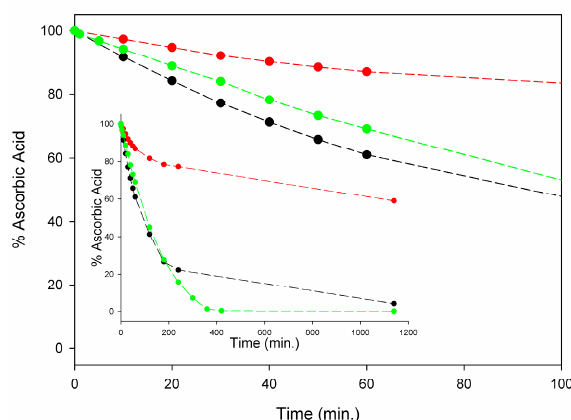
Figure 3. Stability of 100 µM ascorbic acid (AH 2 ) in acetonitrile (red), water buffer pH = 7.4 (green) and methanol (black) at 298 K, in the presence of atmospheric oxygen. Insert shows the full time-course of AH 2 decay expressed as remaining % of the starting concentration, while main graph represents the scale expansion for the first 100 min (kinetic analysis is shown in Figures S4–S6).